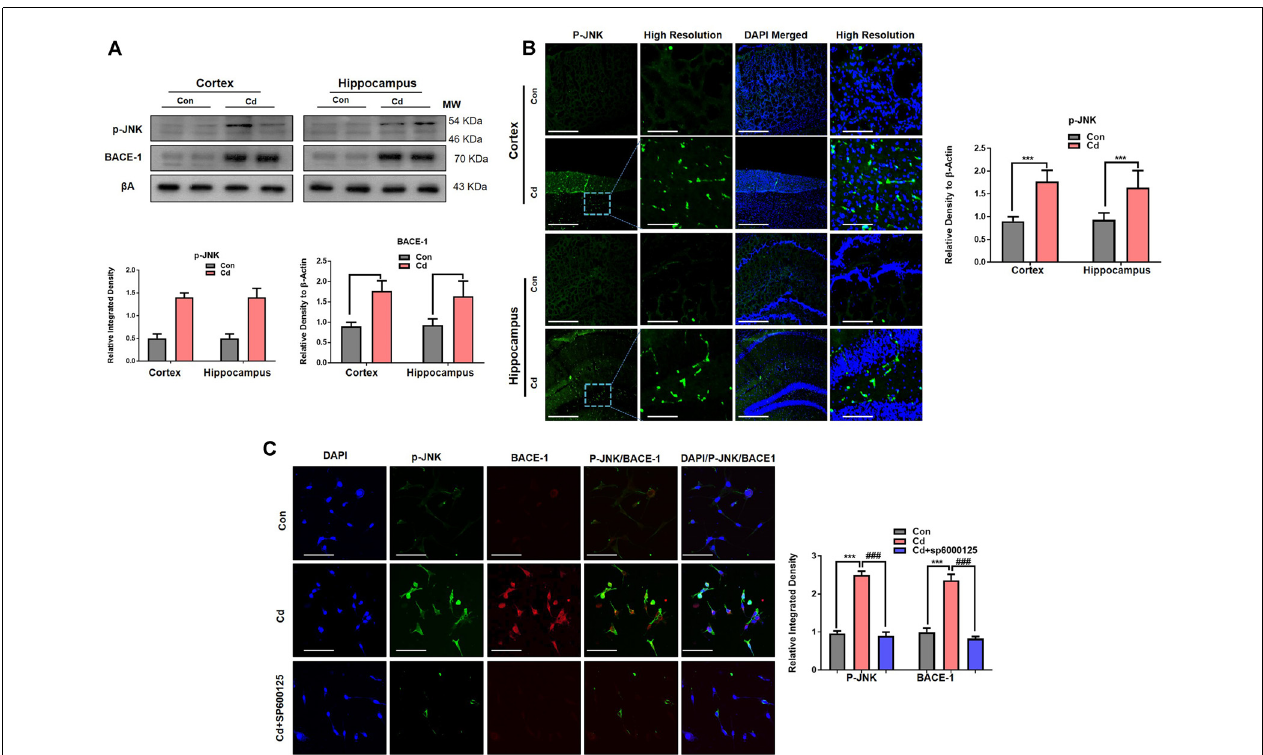
FIGURE 6 | Cd exposure increased the expression of p-JNK and BACE-1. (A) Western blot images against p-JNK and BACE-1 in the cortical and hippocampal regions of the brain and their respective histograms. β -Actin was used as a loading control. The histograms represented as the means ± SEM ( n = 7 mice/group) for three repeated independent and reproducible experiments. Significance = *** p < 0.001; ### p < 0.001 Student’s unpaired t -test. See Supplementary Figure 3 for uncropped and original blots. (B) Representative immunofluorescence images of p-JNK (green: FITC and blue: DAPI) in the cortical and hippocampal regions of the mouse brain. The histograms represented as the means ± SEM for n = 5 mice per group, and the number of independent experiments = 3. Magnification: 10 × . Scale bar = 50 µ m. Significance = *** p < 0.001; ### p < 0.001. (C) The double immunofluorescence and co-localization of p-JNK (green: FITC and blue: DAPI) and BACE-1 (red: TRITC and blue: DAPI) in the hippocampal neuronal HT22 cells exposed to Cd (10 µ M) and SP600125 (20 µ M). The data are indicated as the ± SEM for n = 5 images per group, and the number of independent experiments =